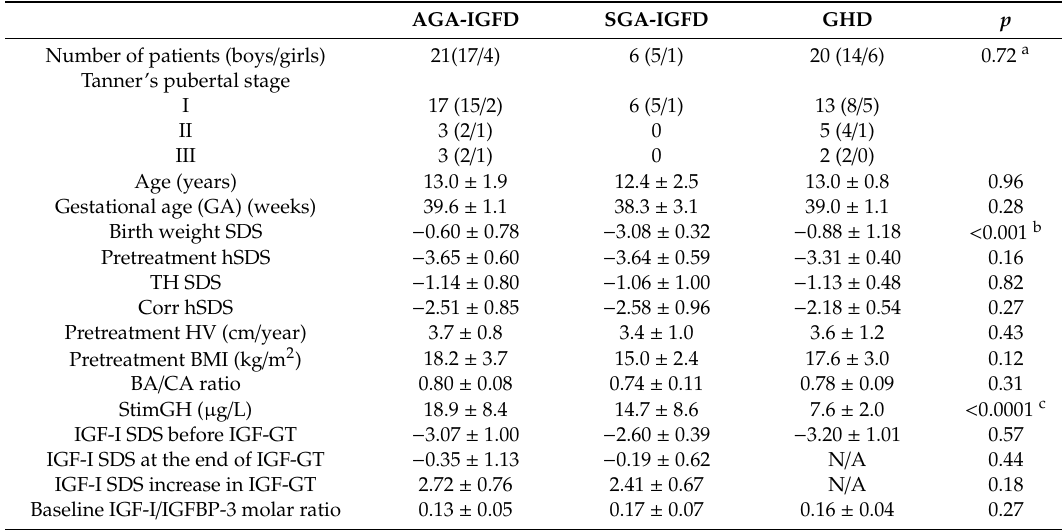
Table 1. Pretreatment Characteristics of Particular Groups of